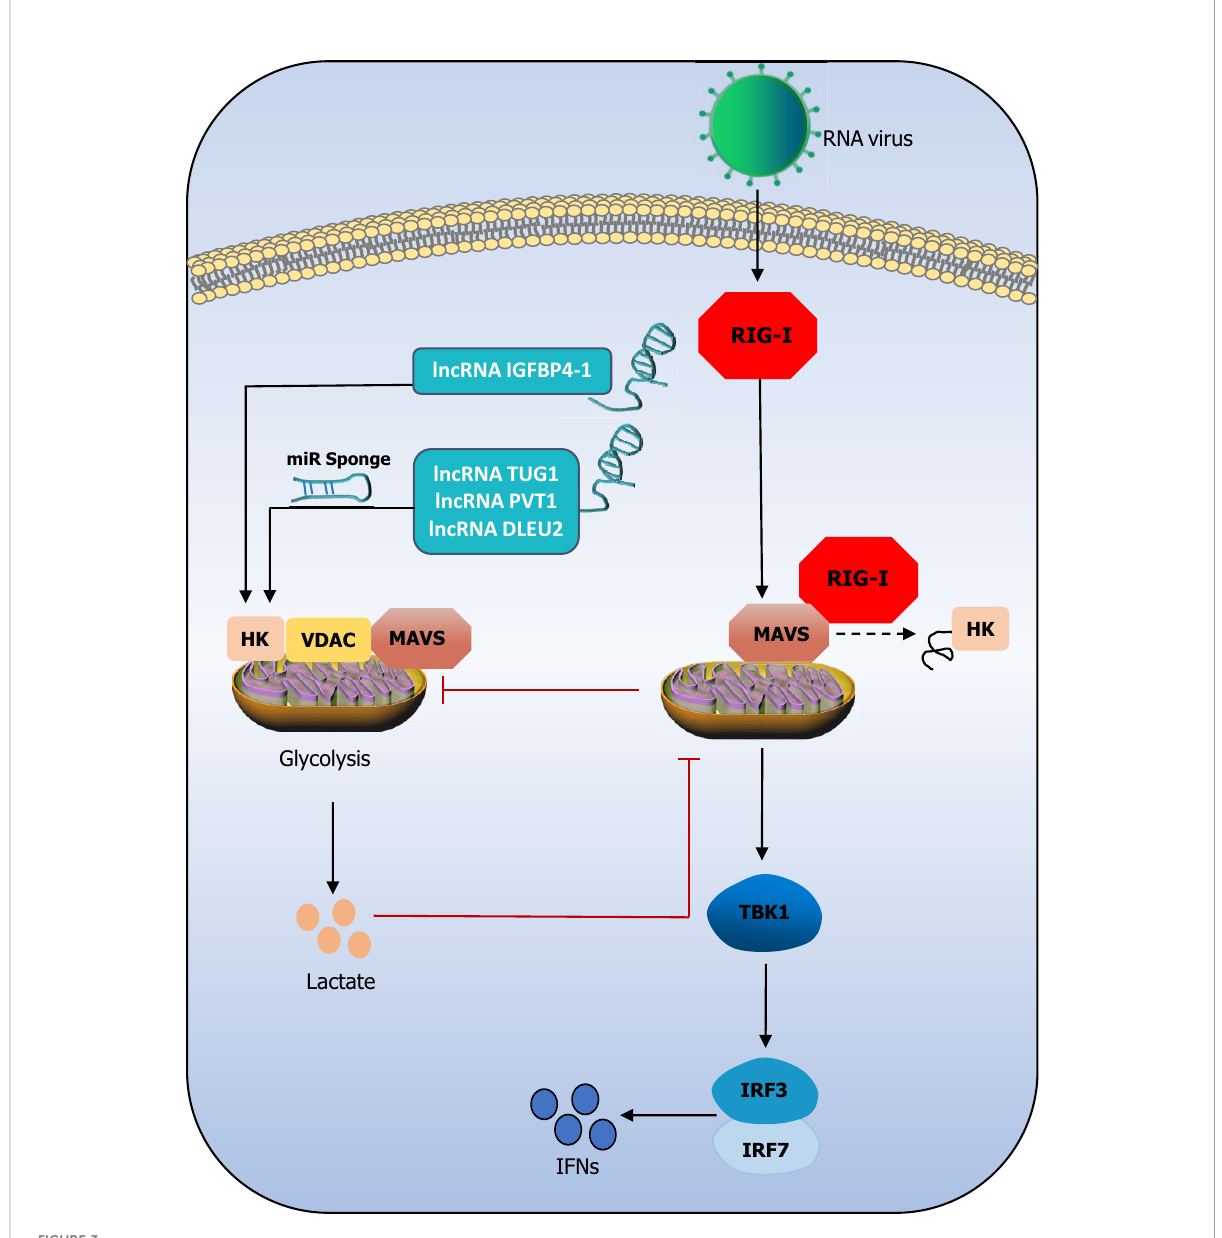
FIGURE 3 The triangle relationship between lncRNAs, the RIG-I signaling pathway, and glycolysis. LncRNAs promote HK activity abd lactate production. Lactate negatively regulates MAVS and subsequently impress TBK1-IRF3 activation and IFN-I production. Mitochondria HK activity inac-tivated, and glycolysis is suffered blocks during RIG-I activation. LncRNA IGFBP4 – 1 increases the expression of HK through their miR sponge. It could be that lncRNAs regulate HK and inhibit the binding of MAVS to RIG-I, thereby inhibiting the intensity of the RIG-I signaling